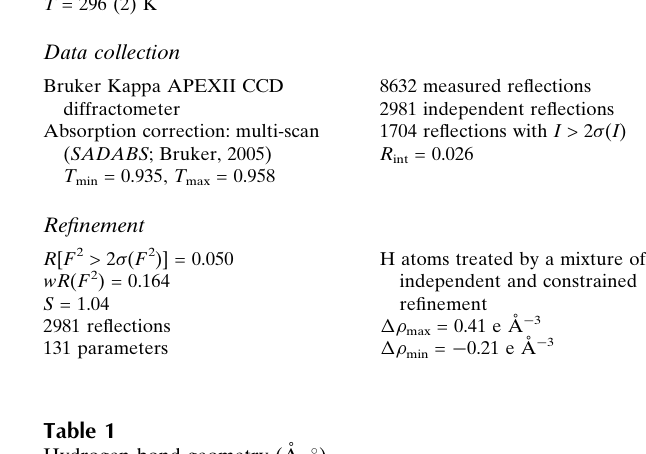
Hydrogen-bond geometry (A˚ , (cid:2) ). D —H (cid:1)(cid:1)(cid:1) A